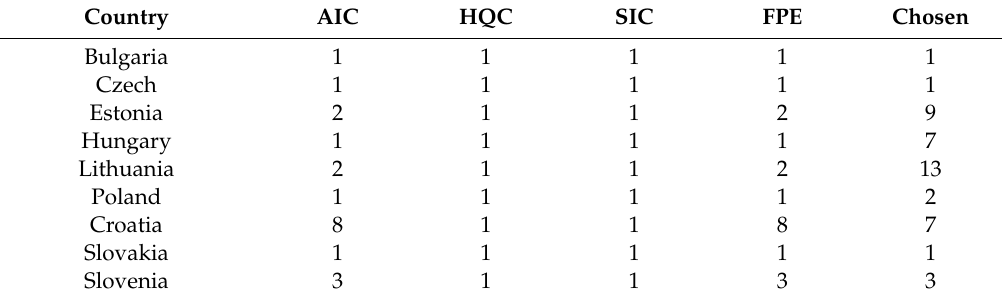
Table 2. Optimal lag value for vector autoregression (VAR) model, di ff erent criteria. Country AIC HQC SIC